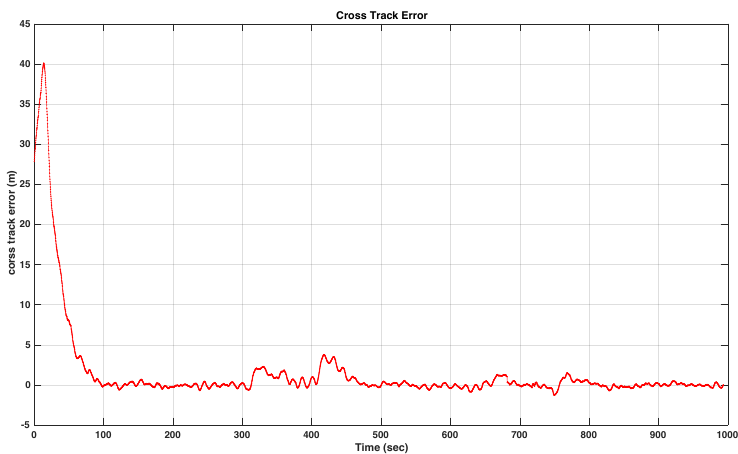
Figure 19. Delfim x cross-track error during the real mission.